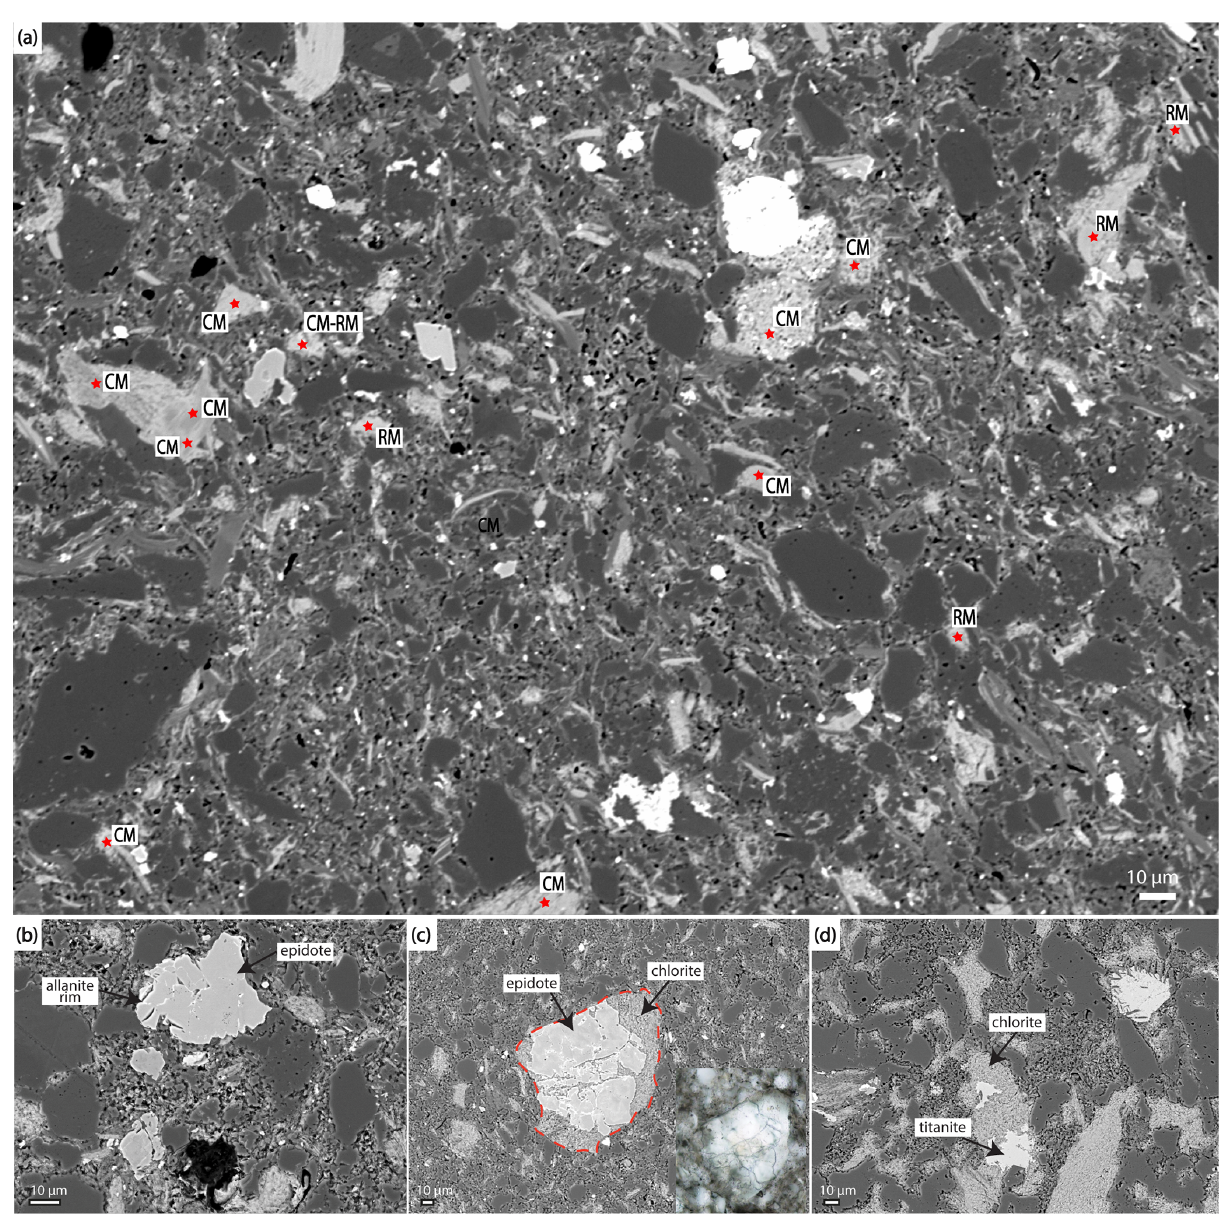
Figure 7. (a) Scanning electron microscope (SEM) image of sample 16-18. Chlorite point analyses are marked by red stars. Label CM indicates chlorites recording contact metamorphic temperatures, and label RM represents chlorites which record regional metamorphic temperatures. (b) Allanite rim surrounding an epidote grain. (c) Optical and backscattered-electron images showing retrograde chlorite generation replacing epidote. (d) Retrograde chlorite generation replacing